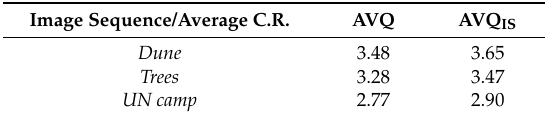
Table 6. Average C.R. (dictionary composed by 8192 entries)–Dataset 2. Image Sequence/Average C.R.